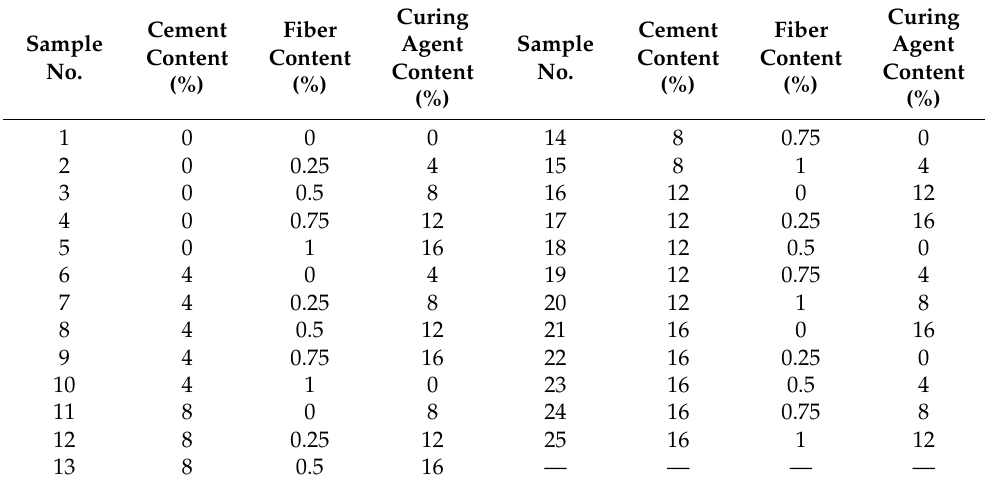
Table 4. Test scheme.